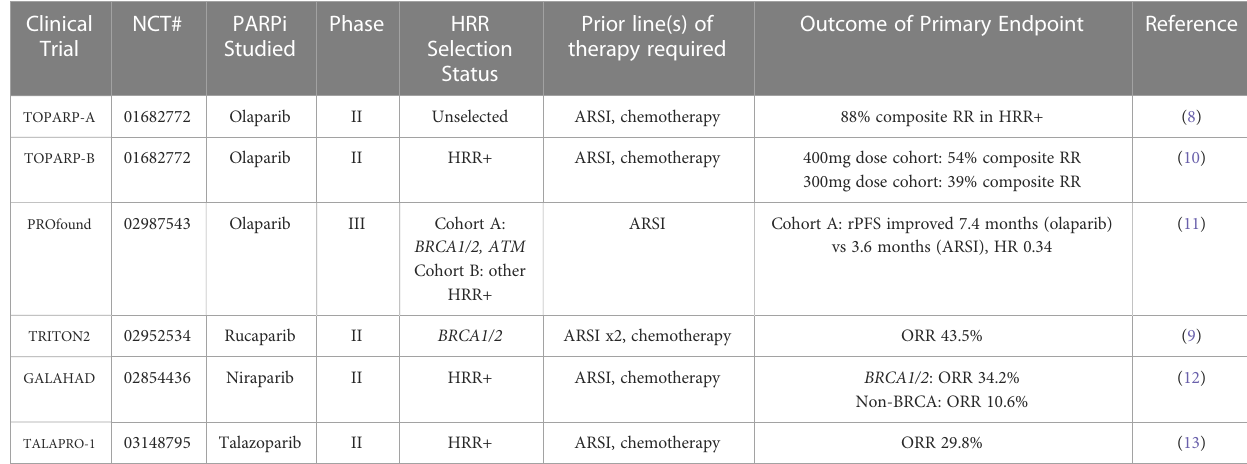
TABLE 1 Completed trials of PARPi monotherapy in mCRPC.